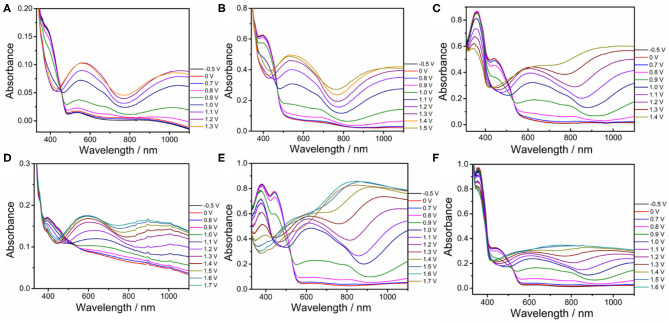
Spectroelectrochemical traces for PDBT-Th (A), PDBT-Th:Th (B), PDBT-2Th (C), PDBT-Th:2Th (D), PDBT-2Th:Th (E), and PDBT-2Th:2Th (F) on ITO coated glass in CH3CN-Bu4NPF6 (0.1 mol L−1).